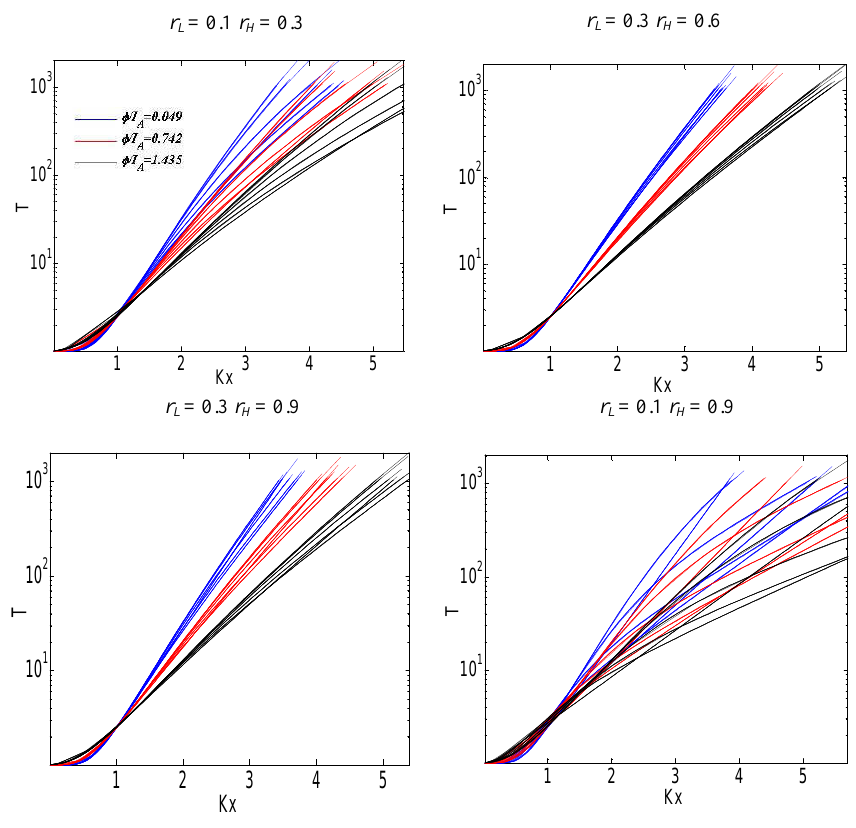
Fig. 4. Growth curves obtained varying φI A (as in the legend), W A /I A (as in Table 4), I 1 (10, 50mmh − 1 ), A (10, 50, 100, 200, 500km 2 ), r L and r H (in